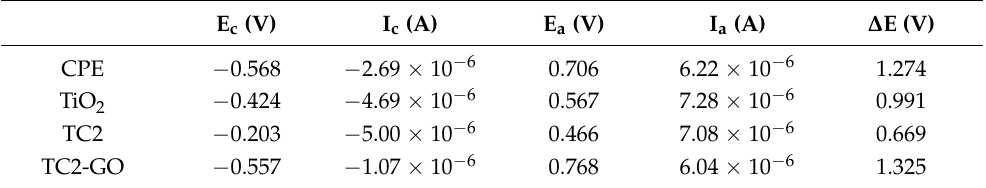
Table 2. Electrochemical data from CV measurements at 100 mV/s; I a and I c represent the anodic and cathodic peak currents, and E a and E c represent the anodic and cathodic peak potentials. E c (V) I c